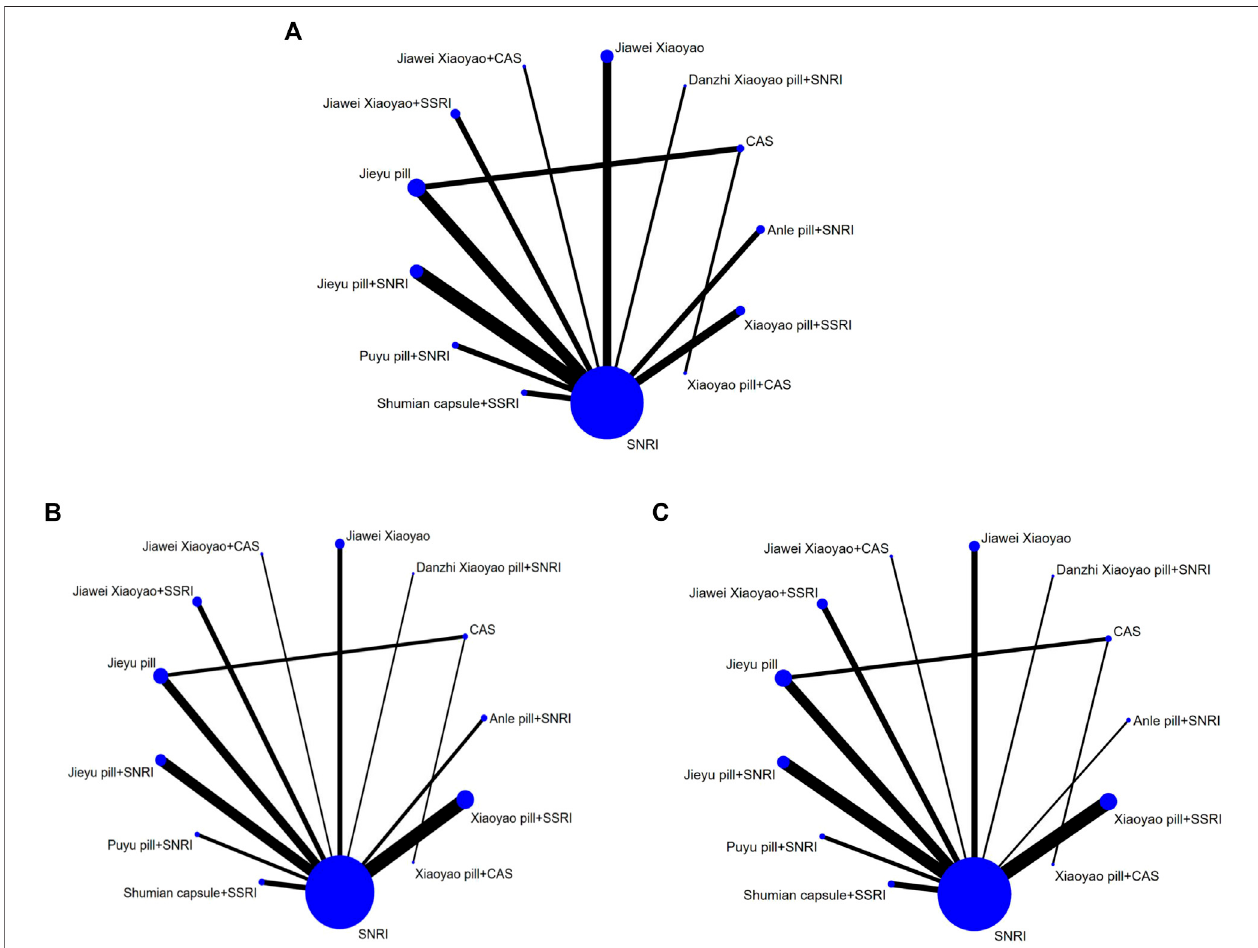
FIGURE 3 | Evidence network of (A) total effective rate, (B) HAMD, and (C) adverse reactions.